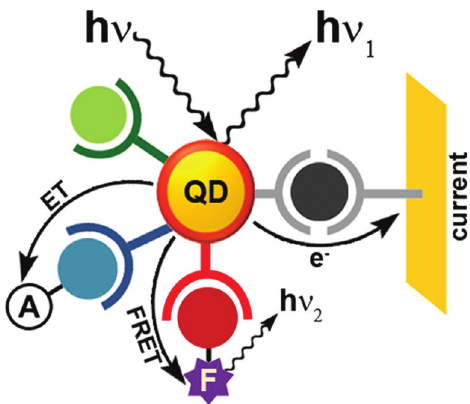
Figure 7 Schematic representation of different QD-based sensing configurations using (A) luminescence, (B) electron transfer, ET, (C) FRET, or (D) photocurrent generation as readout signals. Reprinted with permission from: Freeman et al. 2013. Copyright 2013, Ameri- can Chemical